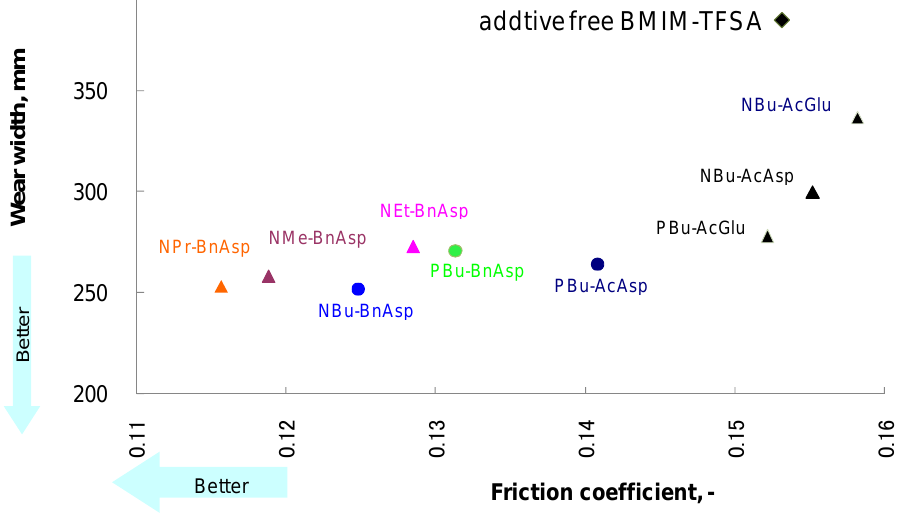
Figure 5. Additive effect on friction and wear for